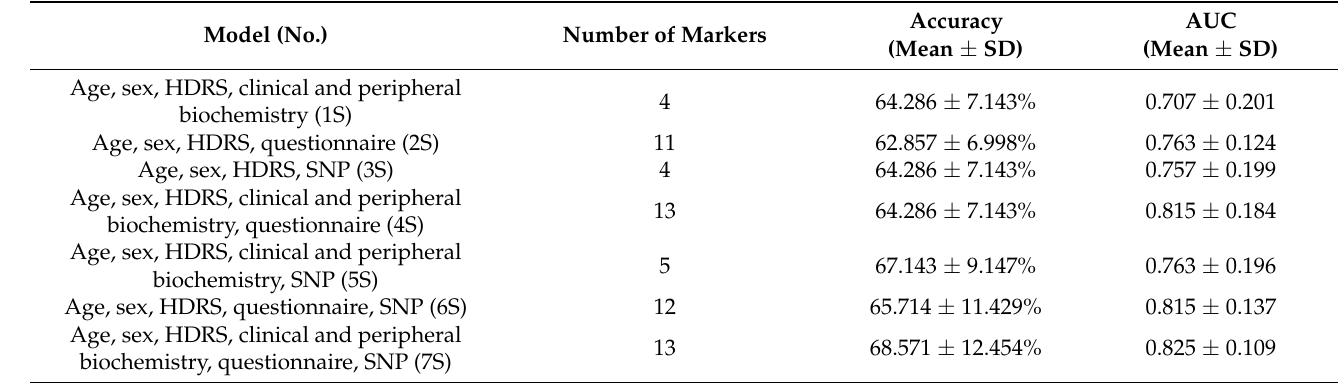
Table 6. The result of each model with a combination of selected data from different domains for predicting the treatment outcome (remission or nonremission) using multilayer feedforward neural networks with two hidden